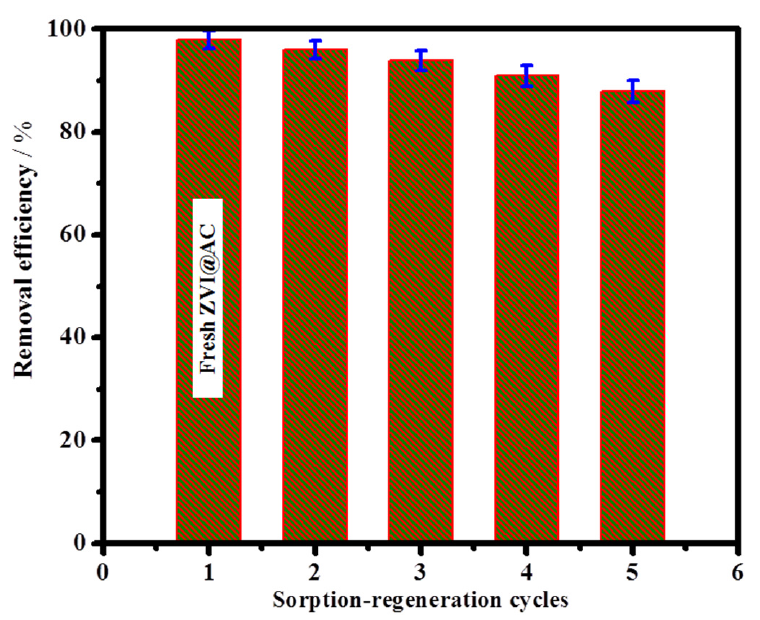
Figure 5. Regeneration of ZVI@AC (Fe(0)@AC) sorbent (100 mL of 100 ppm Cr(VI), 25 °C, 0.6 g sorbent and).